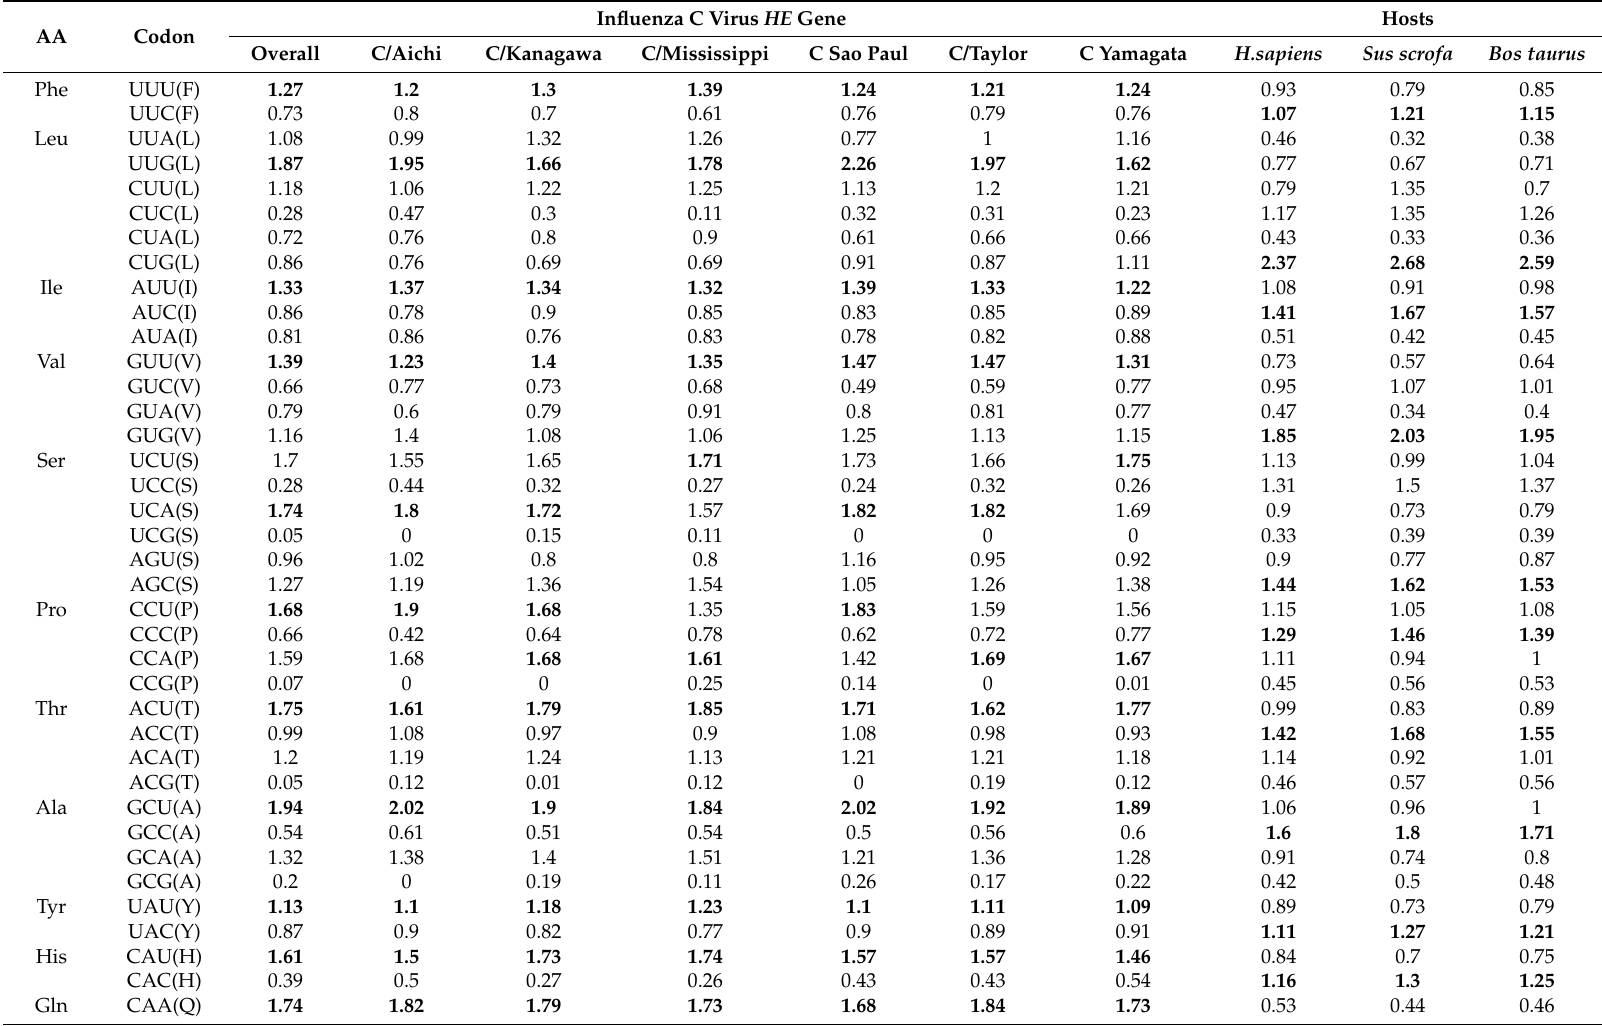
Table 1. The relative synonymous codon usage (RSCU) patterns of ICV and its